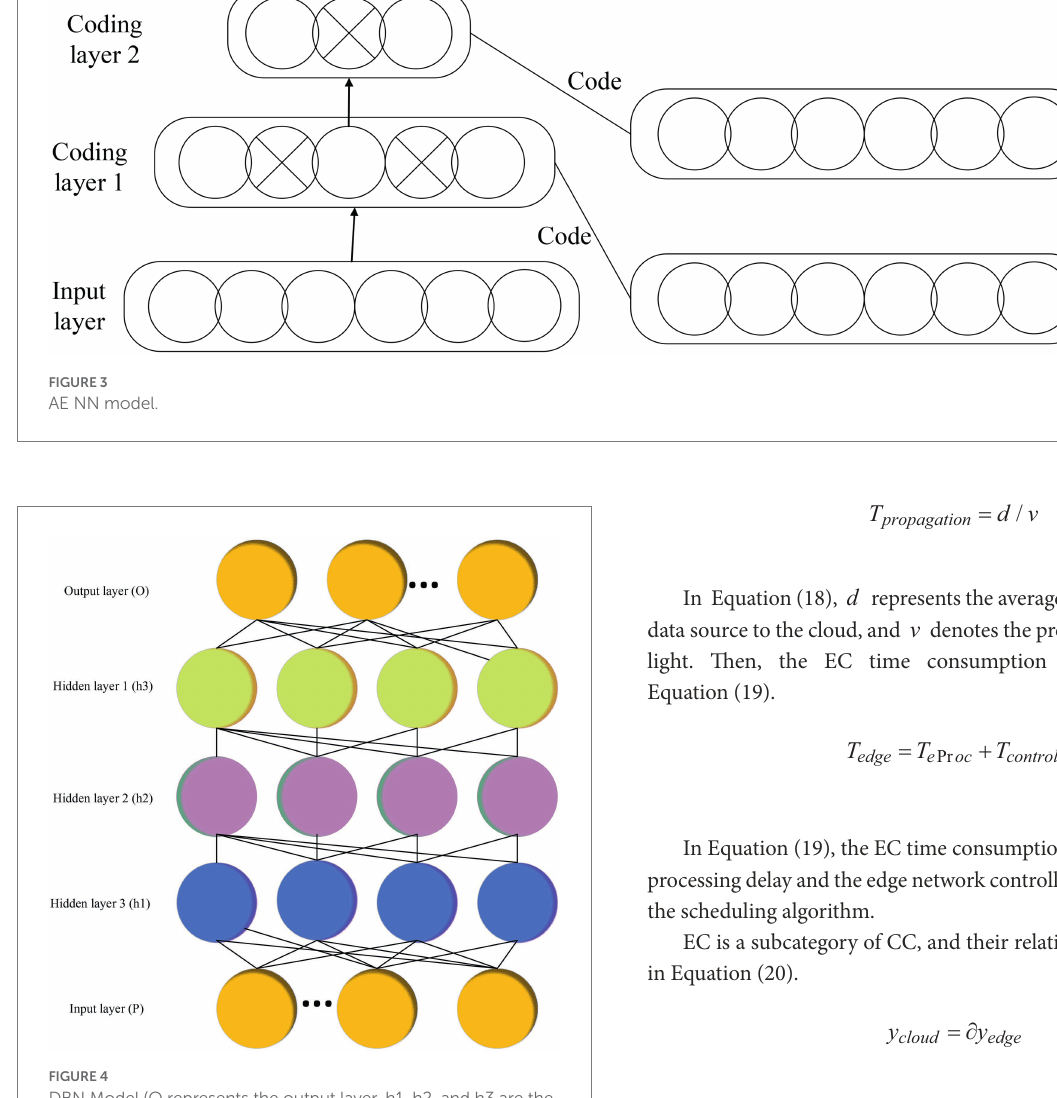
FIGURE 4 DBN Model (O represents the output layer. h1, h2, and h3 are the different weights of the hidden layer. P denotes the input